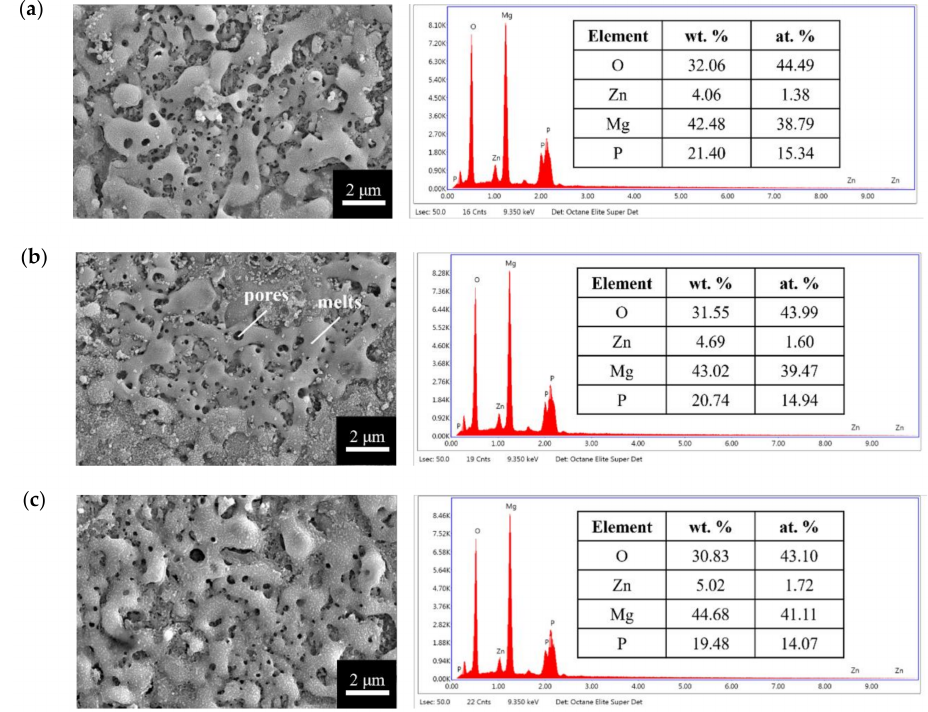
Figure 2. Surface morphologies and EDS spectra of the anodic coatings prepared at 250 V for ( a ) 5 min, ( b ) 10 min, and ( c ) 25